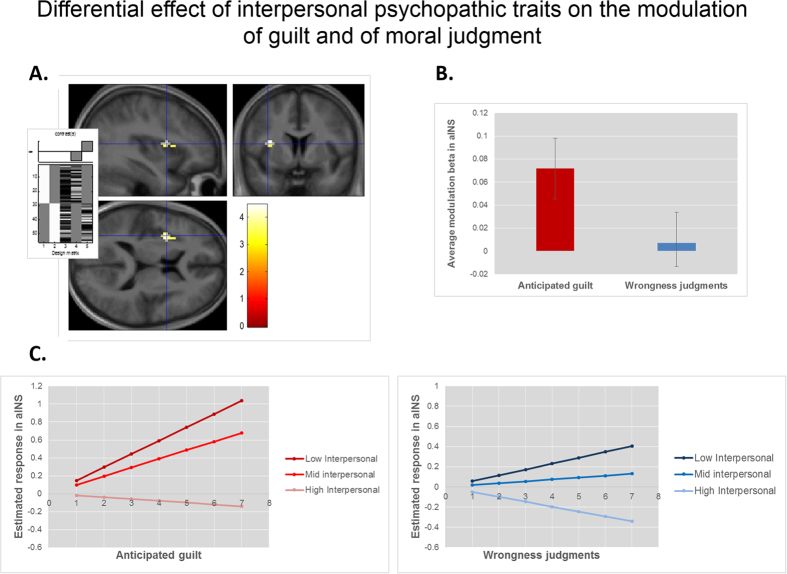
Modulation of feelings of guilt and wrongness judgments in anterior insula.(A) Cluster in the anterior insula where psychopathic interpersonal traits were associated with the modulation of activation by feelings of anticipated guilt, but not by wrongness judgments ([x, y, z: −36 5 13], k = 23, Z = 4.08, p > 0.05, SVC). The overlay is thresholded at p < 0.001 (uncorrected). Inset: second level SPM design matrix showing the contrast; columns (left to right) represent: 1) parametric modulation of anticipated guilt feelings (from Study 1); 2) parametric modulation of wrongness judgments (from Study 2); 3) age; 4) and 5) interpersonal psychopathic traits from Studies 1 and 2, respectively. (B) Bars depict the average regression slopes between trial-by-trial guilt/moral judgment ratings and BOLD response at the anterior insula peak voxel (from A); error bars represent standard errors of the mean. (C) Graphs illustrate the simulation of the modulation of activation by anticipated feelings of guilt (left) and judgments of wrongness (right) at the anterior insula for individuals with low, medium and high levels of psychopathic traits. For illustrative purposes, modulation betas (i.e. regression slopes between BOLD response and ratings) from the anterior insula peak voxel in A were extracted, participants were divided into tertiles of low, medium and high psychopathic interpersonal traits, and an average modulation beta value was computed for each tertile group and used to estimate the hypothetical BOLD response for each point of the rating scale.